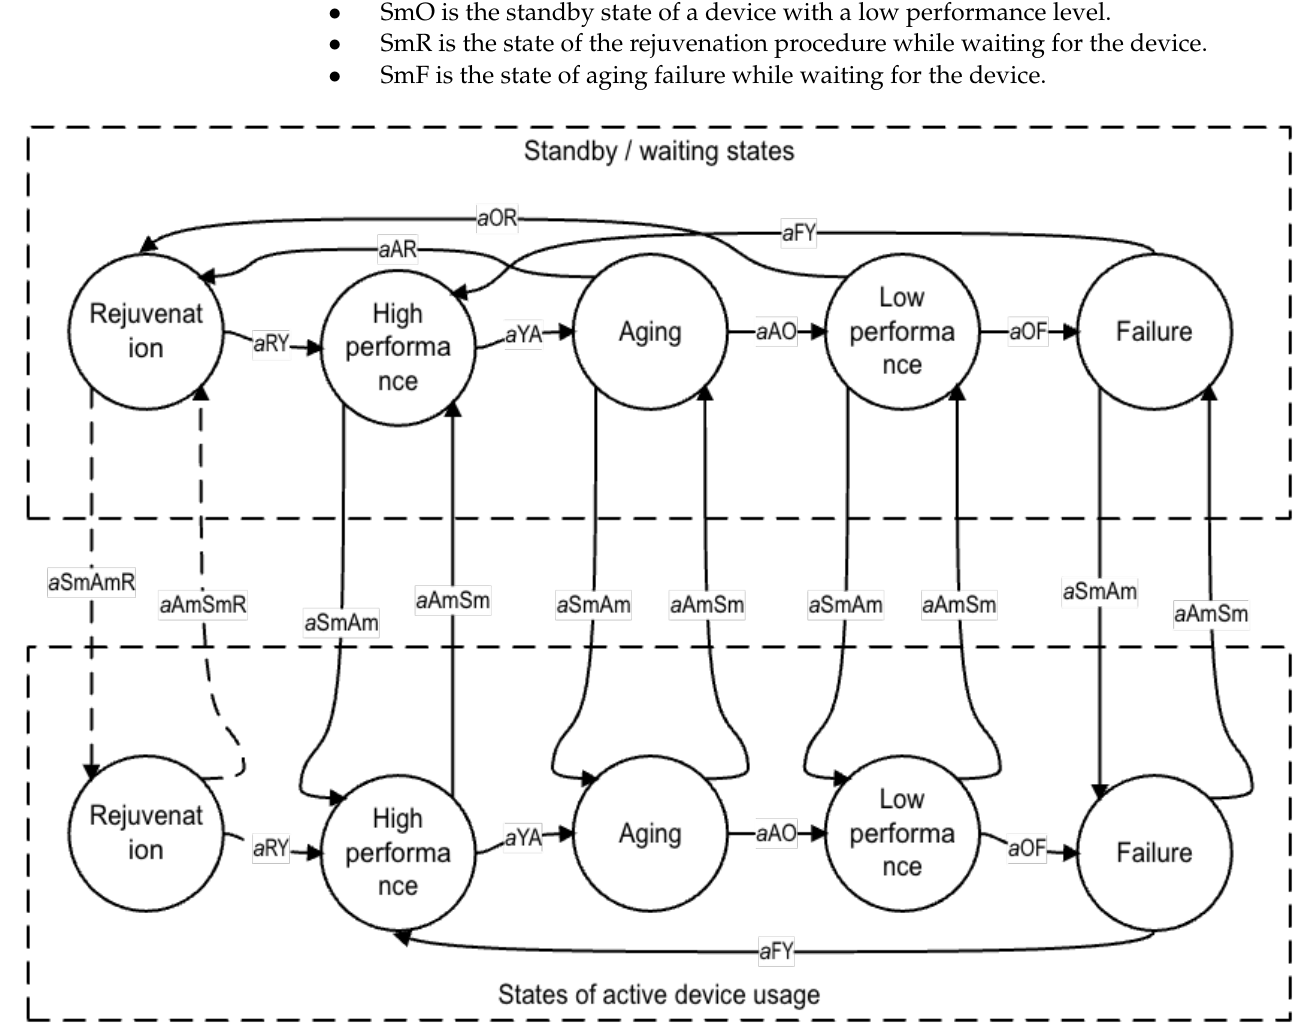
Figure 3. Graph of states and transitions of the aging and rejuvenation model, which considers different levels of aging and user activity of the mobile device [22].